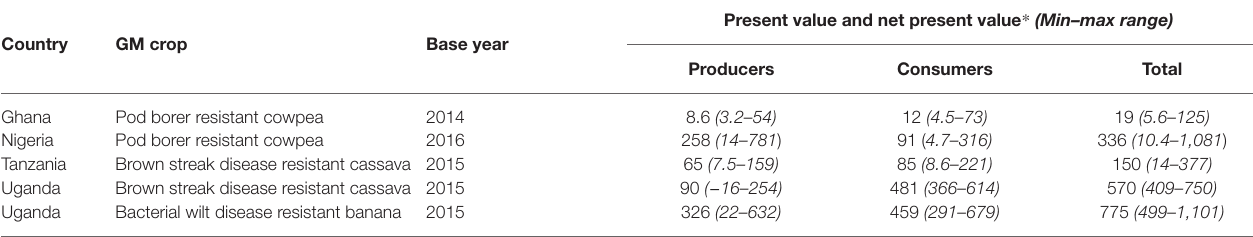
TABLE 3 | Estimated present value of producers and consumers, and total net present value from adopting GM orphan crops by country (millions of US$).